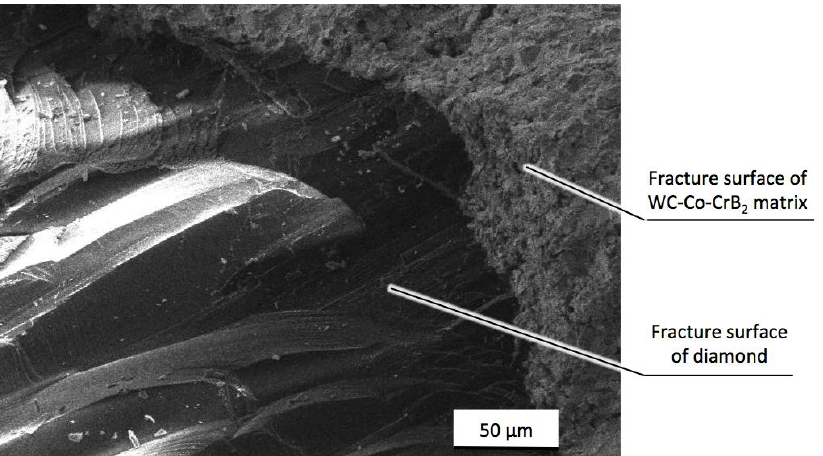
Figure 9. Fracture surface with diamond grit broken but remained hold strongly in the matrix.